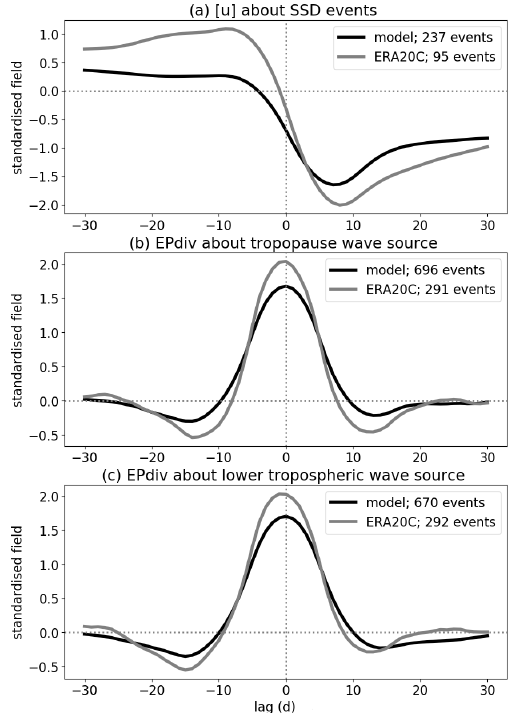
Figure 3. Index definitions shown through lag composites of the rel- evant standardized quantities: (a) zonal mean zonal wind at 10hPa (averaged between 45 and 75 ◦ N) about SSD events, (b) EP flux di- vergence ( k = 2 for the model, k = 1 for ERA-20C) at tropopause about the tropopause wave-source events, and (c) EP flux diver- gence ( k = 2 for the model, k = 1 for ERA-20C) in the lower tro- posphere about the surface wave-source events. Note that EP flux divergence was averaged between 40 and 60 ◦ N in the model and between 45 and 75 ◦ N in ERA-20C. Lag zero is the date when the index maximizes (i.e., index central date). The lines denote differ- ent datasets: black lines for the model and grey lines for ERA-20C. Note that the data were smoothed by a 10d running mean before